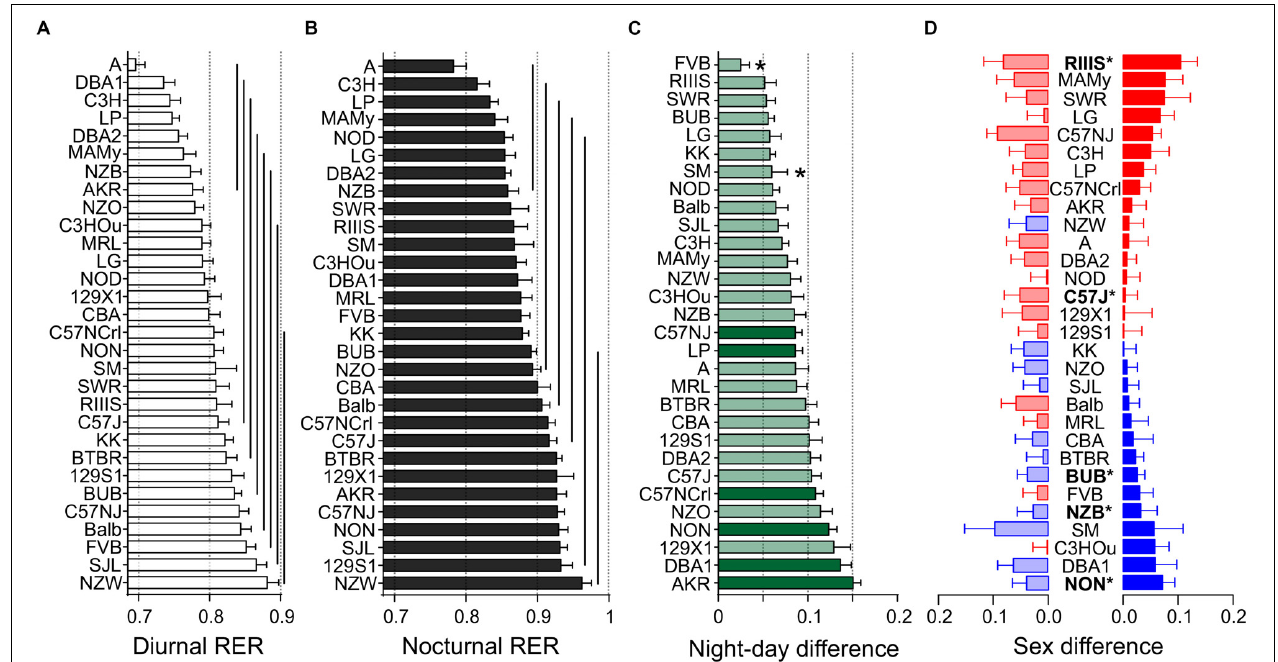
FIGURE 6 | Strain, day–night and sex differences in RER. Distribution of diurnal (A) and nocturnal (B) RER values. The values are given as mean values averaged from both sexes with standard errors of the mean and the vertical lines connect groups with homogenous means according to Tukey’s post hoc test. (C) Day–night differences were ranked and Cohen’s D calculated. Significant differences at p < 0.006 are indicated with asterisk and p -levels < 0.001 were not marked. The effect sizes ranged from D = 0.54 (FVB) to D = 3.71 (AKR) and are indicated in light green ( D = 0.54 and D < 2) and dark green ( D ≥ 2). (D) Sex differences were apparent in five strains at p < 0.05. The strains are ranked from largest to smallest sex difference for the scotophase, beginning, at the top, with strains, where females (red) had higher RER than males, while blue columns illustrate the opposite. To the left, nocturnal values are associated with the respective diurnal values and are displayed in light colors. All values are displayed as means ± standard error of the difference. Asterisks and bold font indicate significant sex differences, * p <